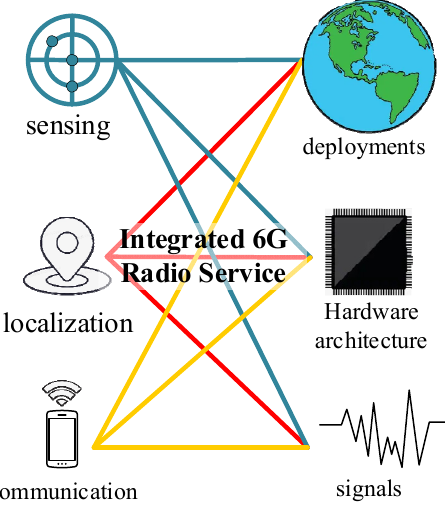
Figure 2. Integrated 6G radio service.